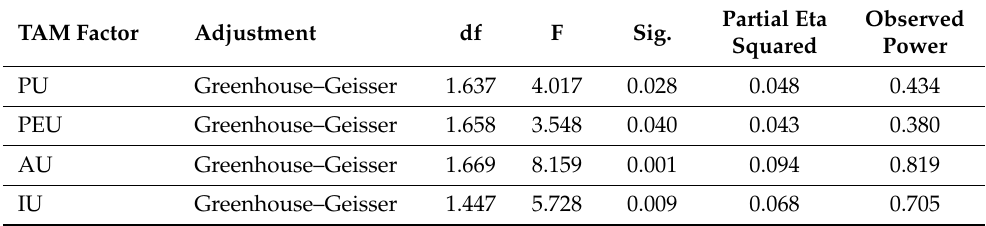
Table 12. Tests of within-subjects effects per individual TAM